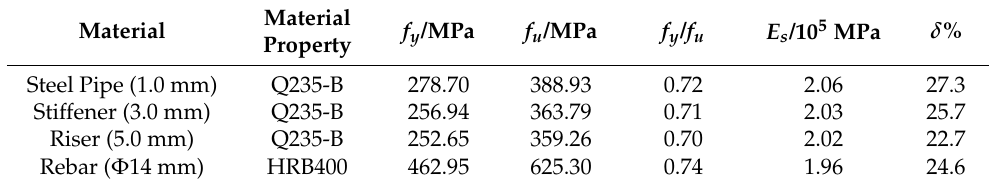
Table 2. Material properties of steel.